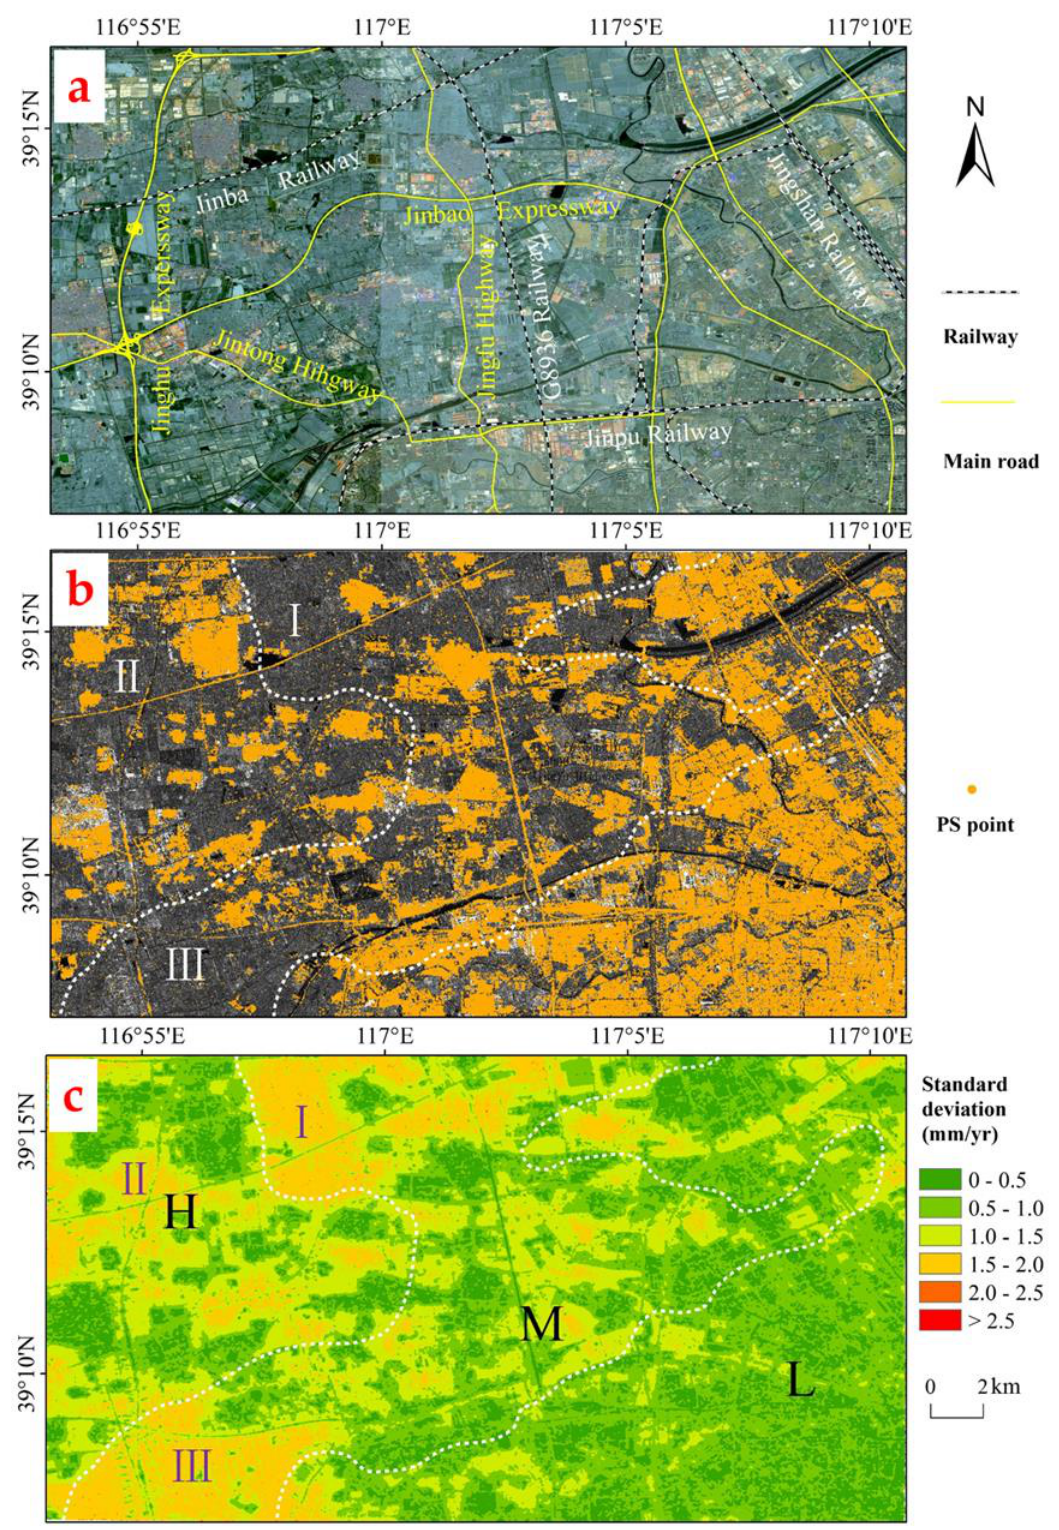
Figure 11. ( a ) Distribution of main roads and railways in the study area, superimposed on the Sentinel-2A images. ( b ) PS points’ distribution. ( c ) The standard deviation of mean subsidence velocity derived by SBAS.